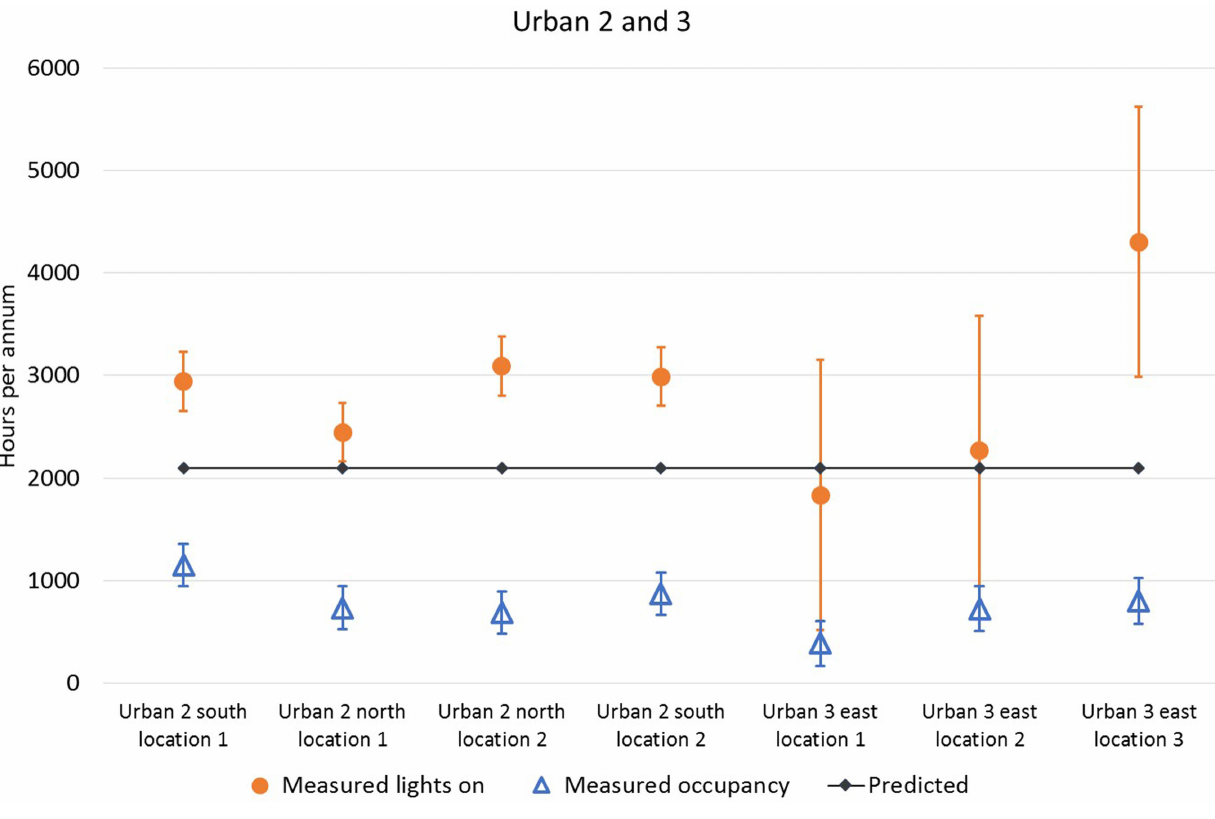
FigUre 9 | Predicted operational hours and measured hours per annum in the Urban